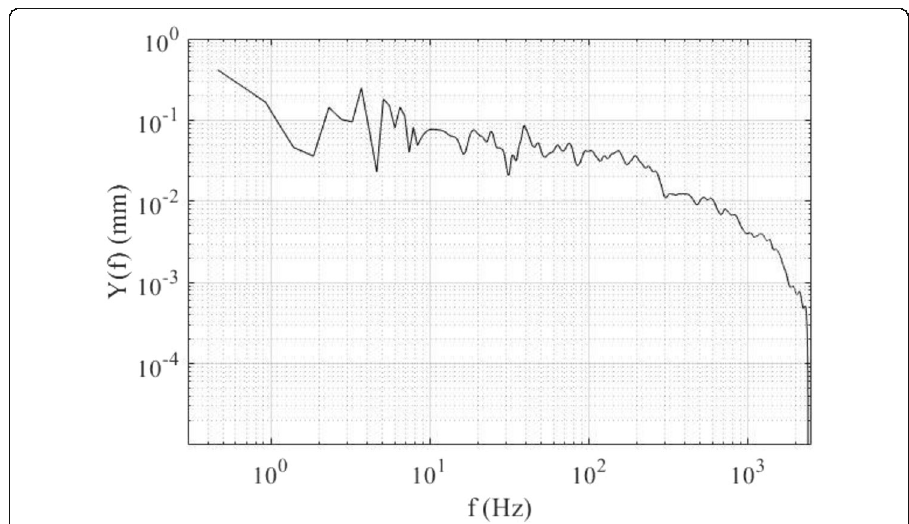
Fig. 13 Spectral energy distribution associated with the shock wave position (relative to average shock wave position) as a function of frequency for data acquired on 05 April 2018